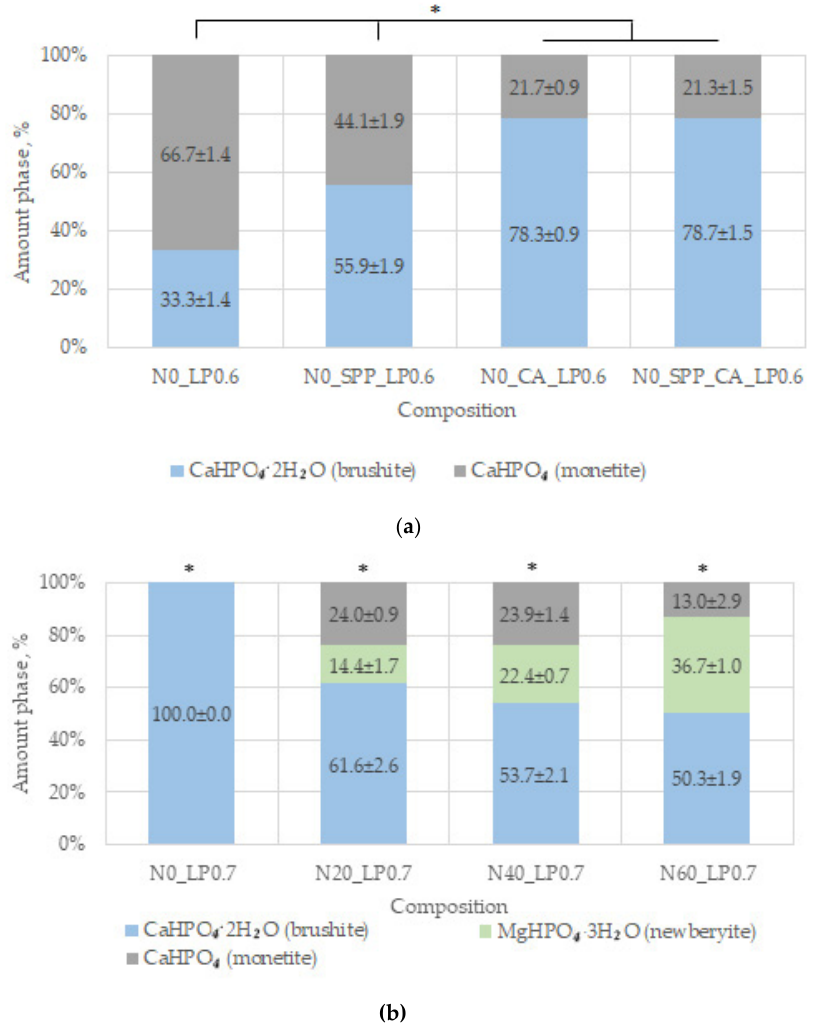
Figure 9. Quantitative phase composition of ceramics: ( a ) N0 when setting retarders are introduced, ( b ) magnesium containing SPP and CA after incubation of physiological solution. Significant differences are labeled with * ( p < 0.05).